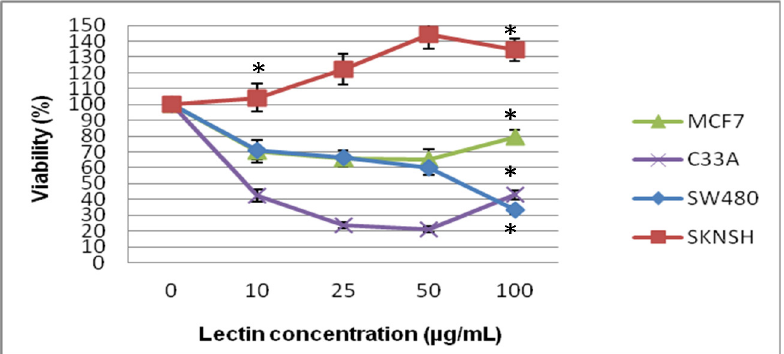
Figure 3. Effect of tepary bean lectin on cell proliferation after 24 h of exposure, in SKNSH, SW480, MCF-7, and C33-A cells employing the 3 [H]-thymidine assay. All values are expressed as mean ± SEM of three independent